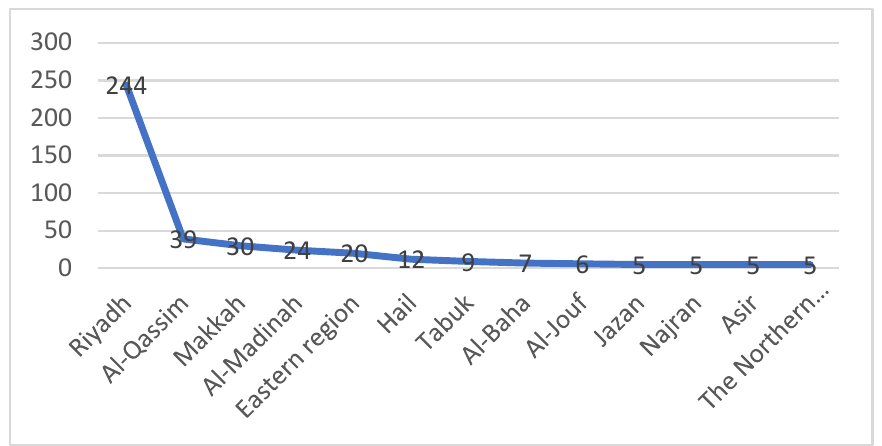
Figure 1. The regions where pharmacists work. Table 2. Employment data of the respondents (n =